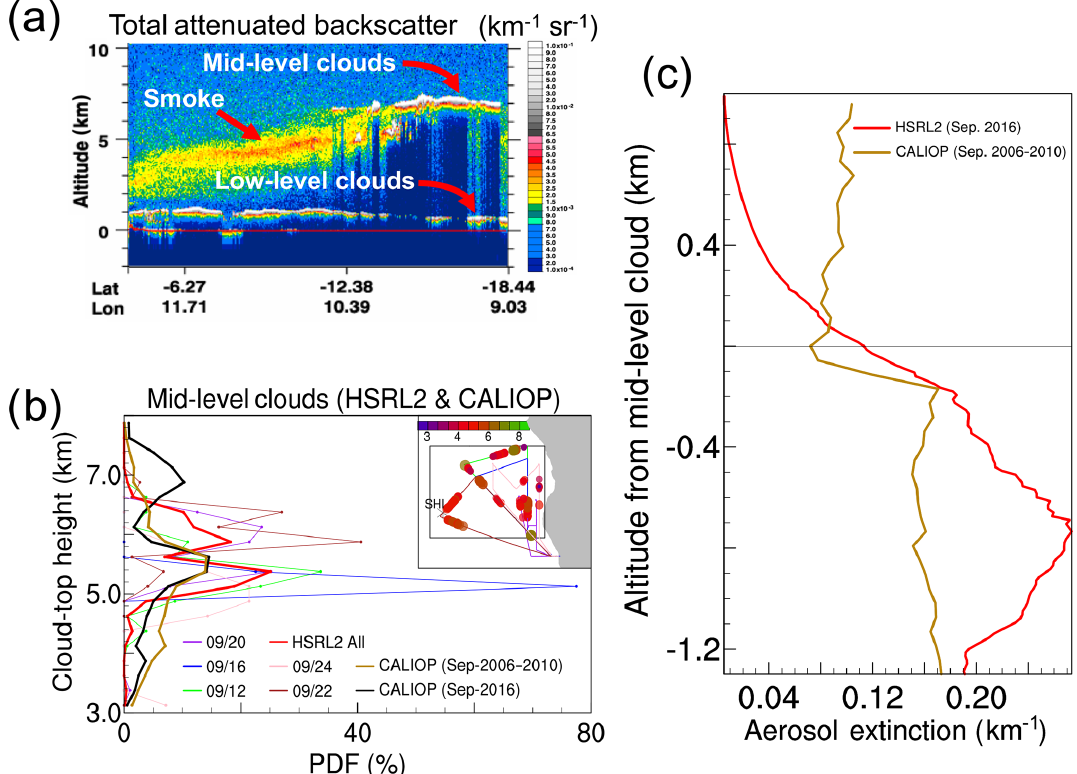
Figure 2. Mid-level clouds over the southeast Atlantic. (a) An example image from CALIPSO showing CALIOP 532nm total attenu- ated backscatter (km − 1 sr − 1 ) with identifiable mid-level clouds, smoke, and low-level clouds on 22 September 2016 between ∼ 00:54 and ∼ 00:57UTC over the southeast Atlantic. (b) The probability distribution of mid-level cloud-top heights (km) measured by the HSRL-2 on board the ER-2 high-altitude aircraft during ORACLES in September 2016. The combined distribution from HSRL-2 is shown by the thick red line, while the CALIOP distribution for all available CALIPSO overpasses for September 2016 and September 2006–2010 are shown by the thick black and brown lines respectively. The inset in (b) shows the spatial locations and heights (km) of the HSRL-2 mid-level cloud measurements, as well as the region for the CALIOP distribution (5–20 ◦ S and 10 ◦ W–12 ◦ E). (c) The 532nm aerosol extinction coefficients (km − 1 ) averaged horizontally for a 0.2 ◦ grid box above and below the mid-level cloud top obtained from HSRL-2 (red line; September 2016) and from CALIOP (brown line; September